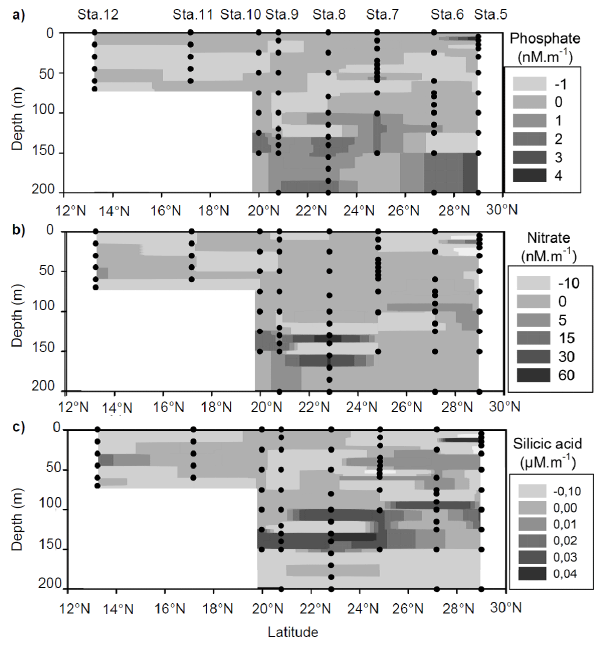
Figure 3. Vertical nutrient gradient (dNutrient/d z ) of Phos- phate (a) , Nitrate (b) and Silicic acid (c) , between stations 5 and 12. The black dots display the sample depths and the names of the stations are indicated in the upper